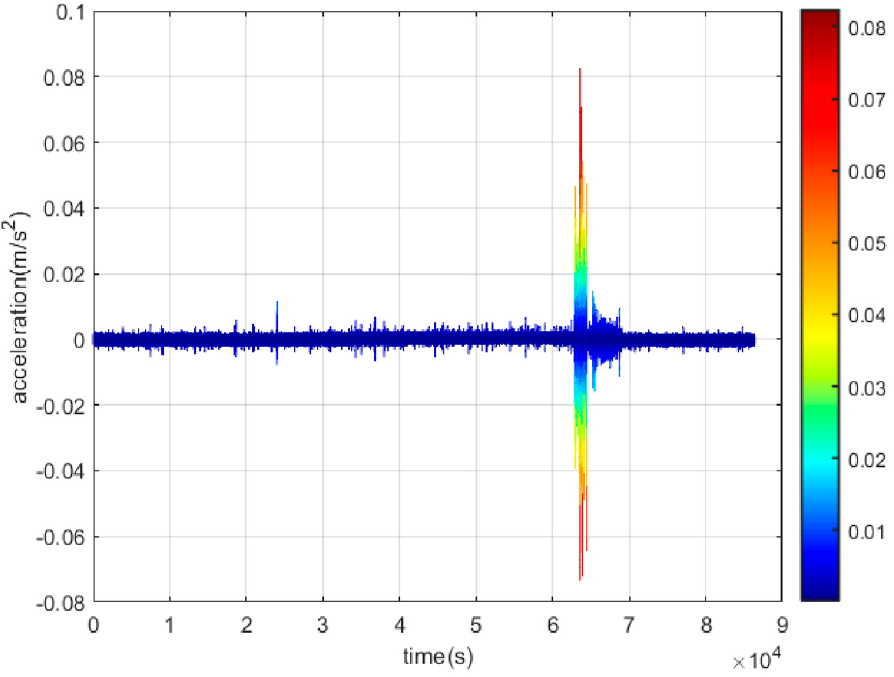
Figure 8. Acceleration time series under thunder loads. Table 3. The weather conditions for 4 August 2022 in Huairou, Beijing.